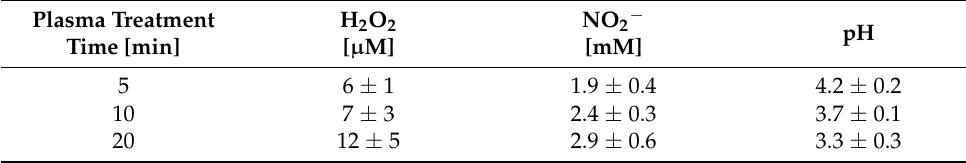
Table 1. Concentration of selected RONS.